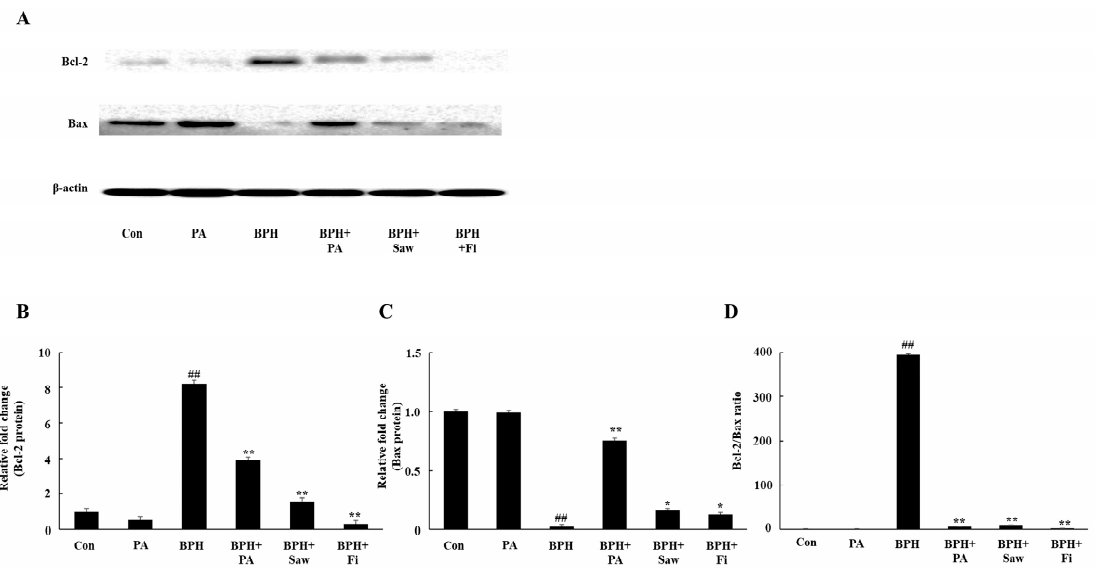
Figure 7. Effect of PA administration on the expression of prostate cell apoptosis-related proteins in rats with TP-induced BPH. (A) Representative western blot showing the bands of Bcl-2 and Bax. (B) Bcl-2 expression in the samples from the rats in each group. (C) Bax expression in the samples from the rats in each group. (D) Bcl-2/Bax ratio in the samples from the rats in each group. Abbreviations: Con, corn oil, s.c. and D.W.-treated rats; PA, corn oil, s.c. and PA 100 mg/kg-treated rats; BPH, TP, s.c and D.W.-treated castrated rats; BPH+PA, TP, s.c and PA 100 mg/kg-treated castrated rats; BPH+Saw, TP, s.c. and saw palmetto 100 mg/kg-treated castrated rats; BPH+Fi, TP, s.c. and Fi 1 mg/kg-treated castrated rats. The data are expressed as the means ± SEMs. # p<0.05 and ## p<0.01, compared with the Con group; * p<0.05 and ** p<0.01, compared with the BPH group.